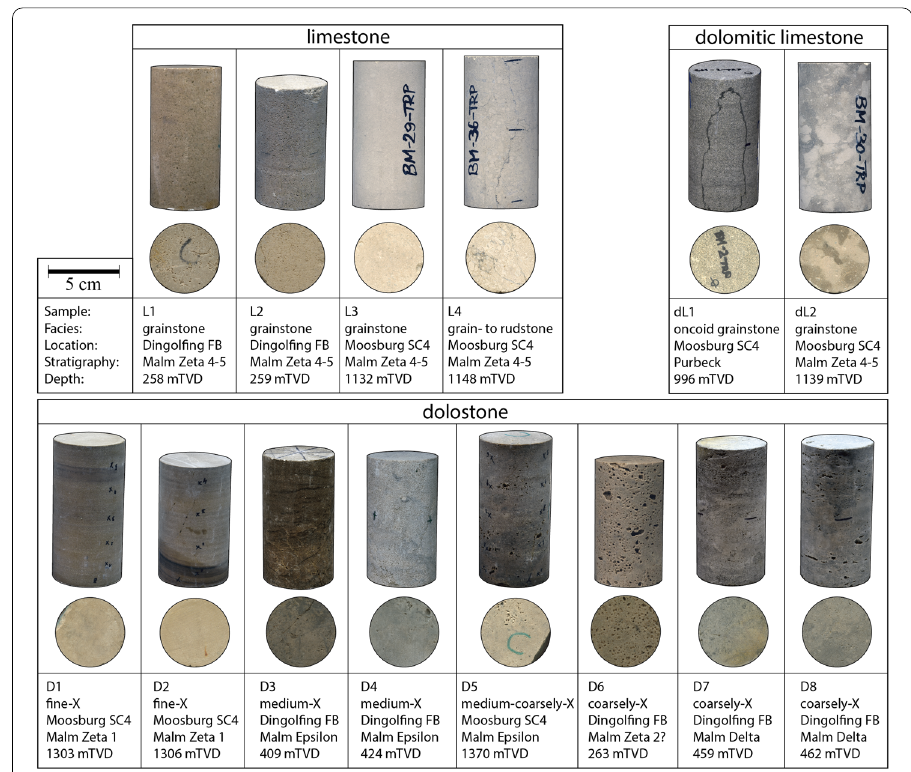
Jurassic of the Bavarian Molasse Basin (X